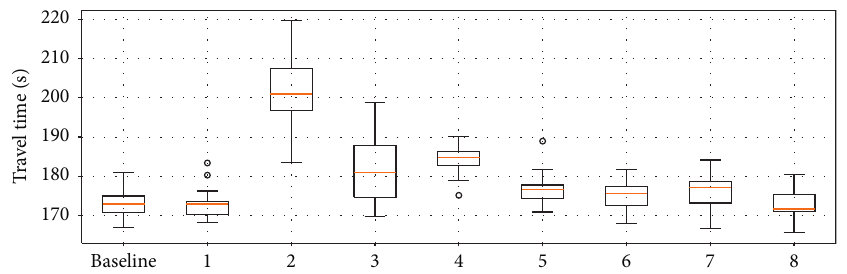
Figure 16: Travel time with perturbed input